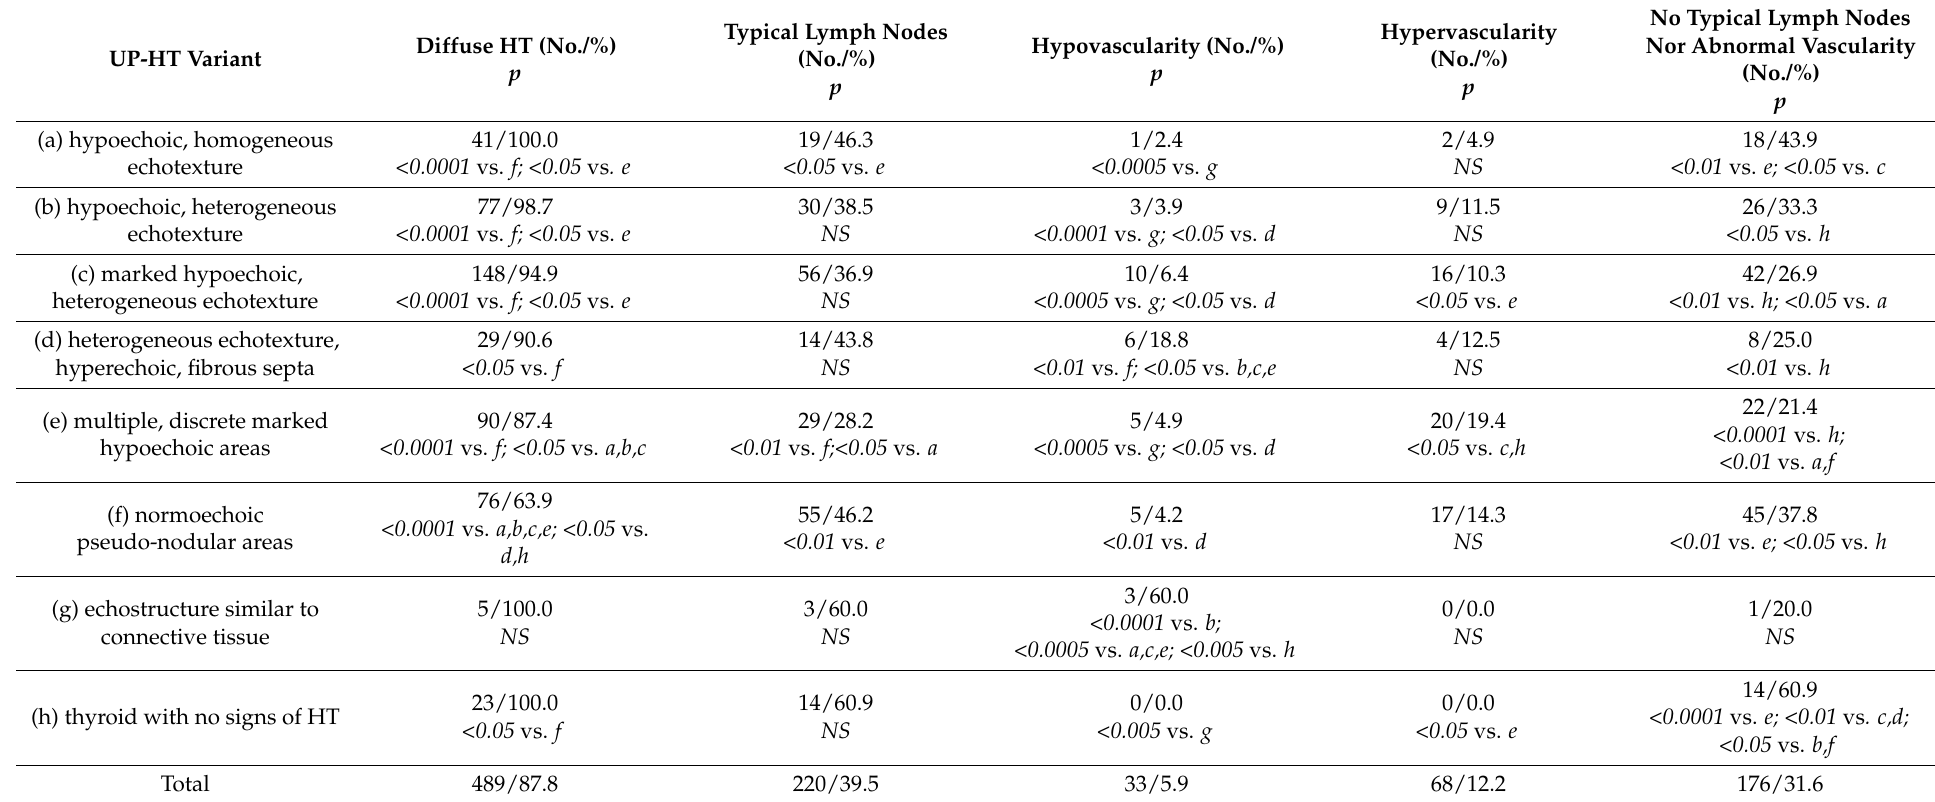
Table 2. Detailed characteristics of ultrasound image of the thyroid parenchyma in patients with Hashimoto (cid:48) s thyroiditis (UP-HT) with regard to the vascularity and presence of lymph nodes typical of